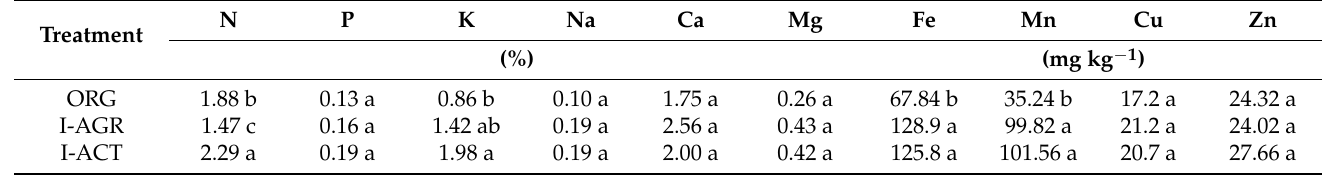
Table 8. Effects of cultivation management on leaf nutrient concentration.